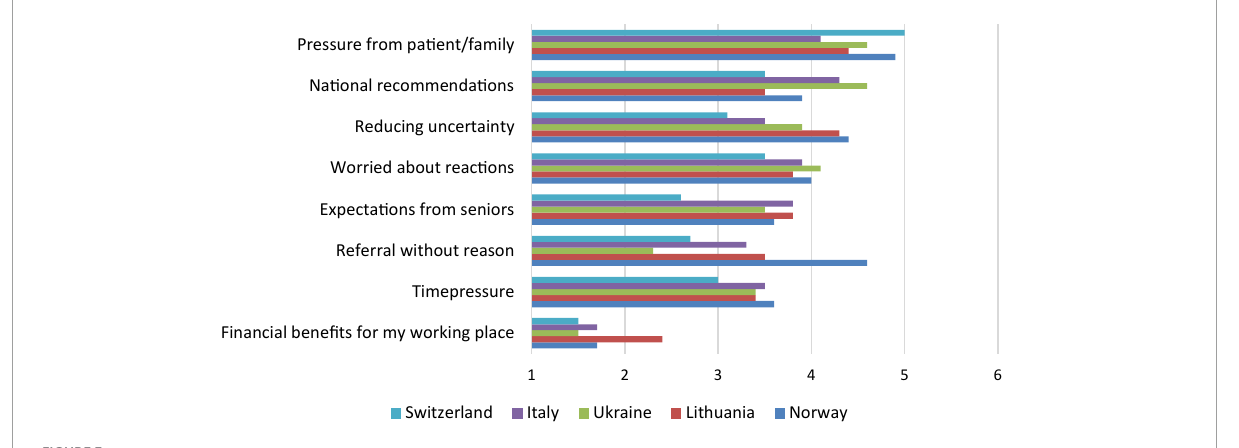
FIGURE3 Responses among different countries to the question “What are by your opinion the main reasons that you overtreat/overinvestigate (n = 909-921)?” Agree-disagree scale data, where 1 = totally disagree, 2 = partially disagree, 3 = slightly disagree, 4 = slightly agree, 5 = partially agree, and 6 = totally